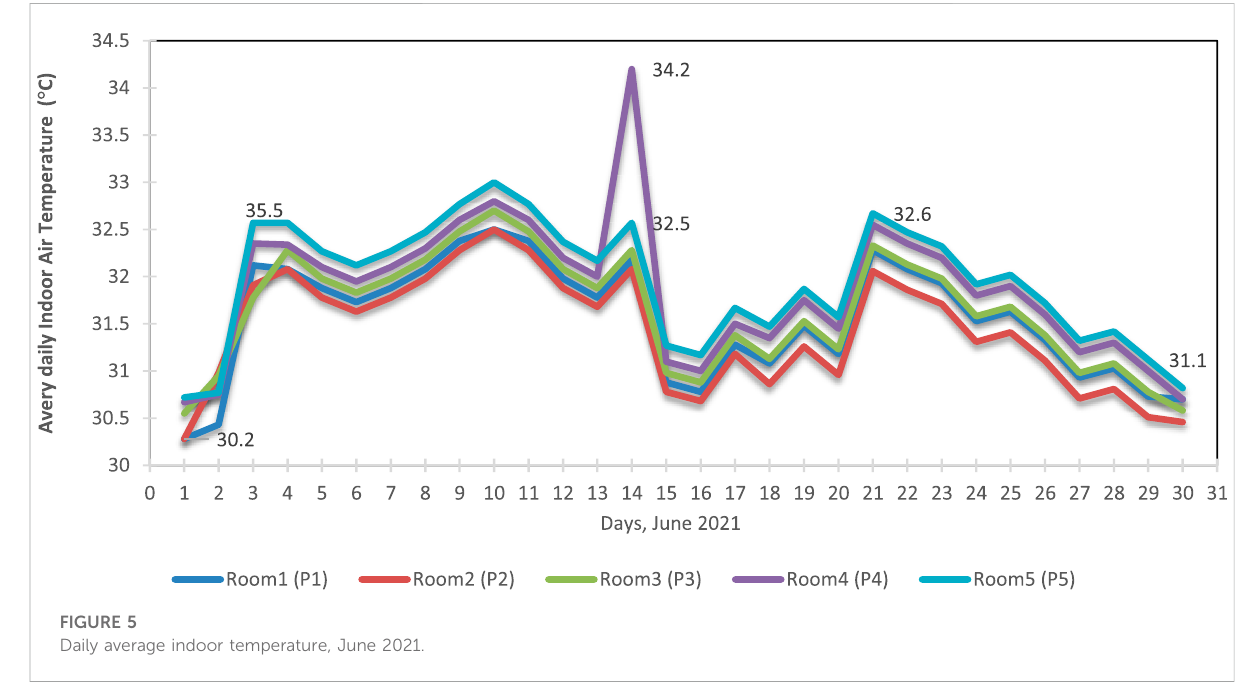
FIGURE 5 Daily average indoor temperature, June 2021.